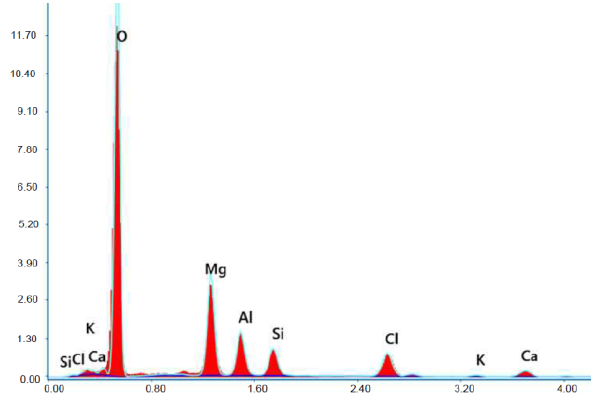
Figure 22. Microstructure of ZIX mortar (FBC III) after 90 days of curing in carbonation chamber.